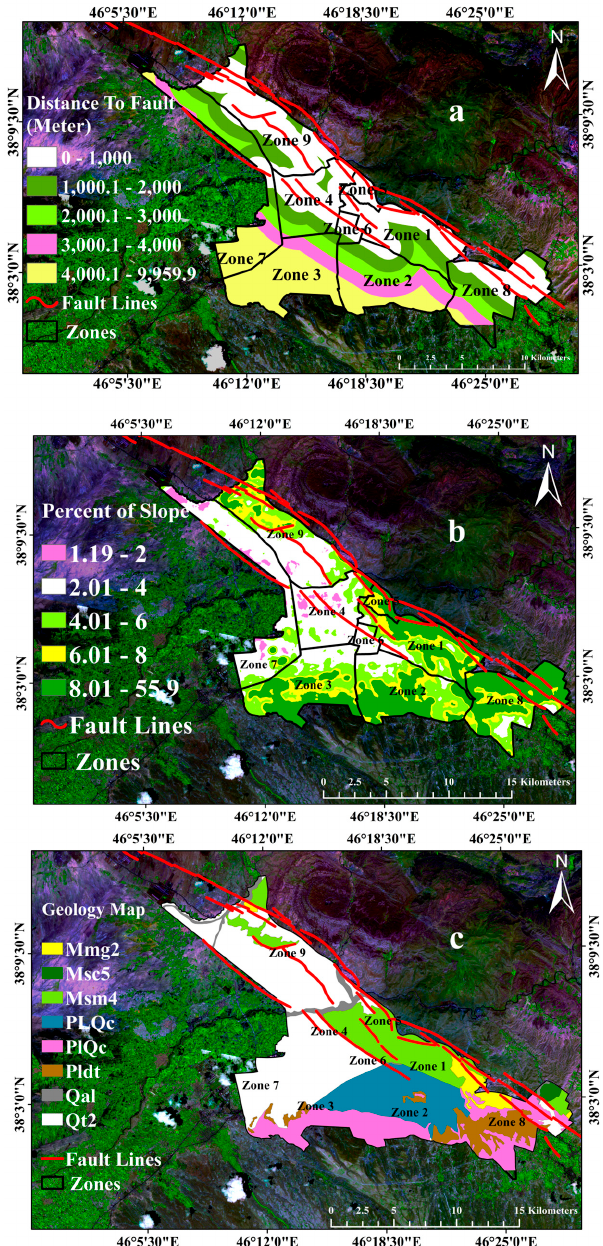
Figure 3. Distribution of ( a ) Fault systems ( b ) Slope gradients and ( c ) Geology map of Tabriz city. Mmg2 = Interlayer of greenish grey marl associated with an interlayer of gypsum- bring sandy marl. Msc5 = Interbedded red conglomerate with sandstone and red marl. Msm4 = Sandstone and red marl. Pldt = Diatomic and fish interbedded with fine particles sediment. Plqc = Interlayer of semi-hard conglomerate associated with sandstone and pumice. Qal = Quaternary alluvium. Qt2 = Young terrace and alluvium